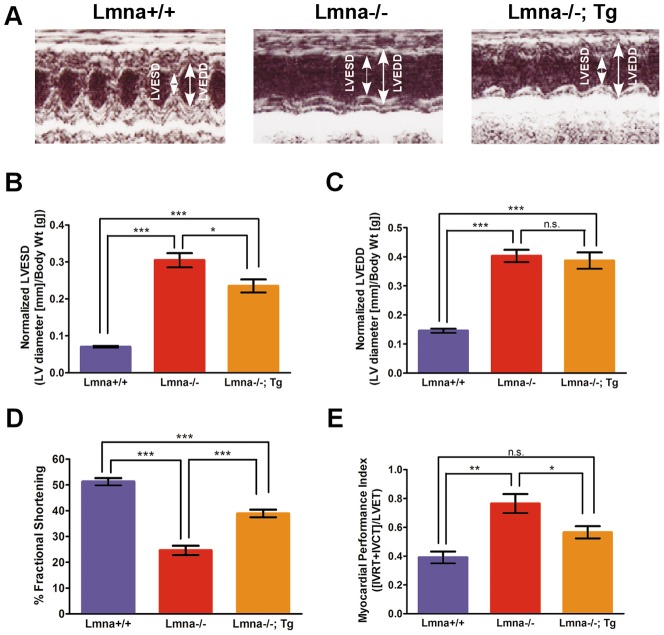

Lmna
−/−; Tg mice display improved contractile function compared to Lmna
−/− littermates.(A) Representative echocardiograms of Lmna
−/−, Lmna
−/−; Tg, and control littermates. (B) Normalized left ventricular end-systolic diameter (LVESD) measurements are increased in Lmna
−/− hearts compared to control hearts and are improved in Lmna
−/−; Tg hearts. (C) Normalized left ventricular end-diastolic diameter (LVEDD) measurements are increased in Lmna
−/− hearts and are not improved in Lmna
−/−; Tg hearts. (D) Fractional shortening is decreased in Lmna
−/− hearts compared to control hearts and is improved in Lmna
−/−; Tg hearts. (E) Myocardial performance index (MPI) is increased (worse) in Lmna
−/− mice, but is improved in Lmna
−/−; Tg mice. For all of the above experiments: Control, N = 13; Lmna
−/−, N = 15; Lmna
−/−; Tg, N = 12 for 4–8 weeks of age. One-way ANOVA analyses were performed (B–E) and significant genotype differences are listed above for each panel. Post-tests were performed between genotypes and significance is listed as follows: * P<0.05; ** P<0.01; *** P<0.001; n.s. not significant.